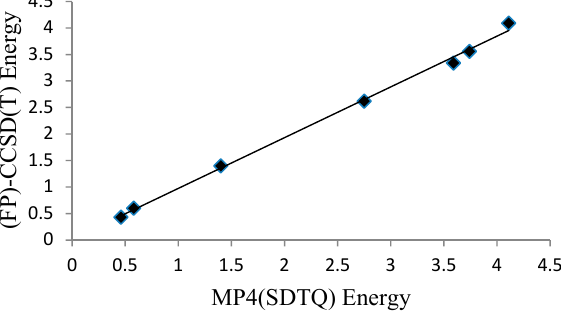
Figure 5. A graph presenting a linear relationship between the MP4(SDTQ) and (FP)-CCSD(T) energies.